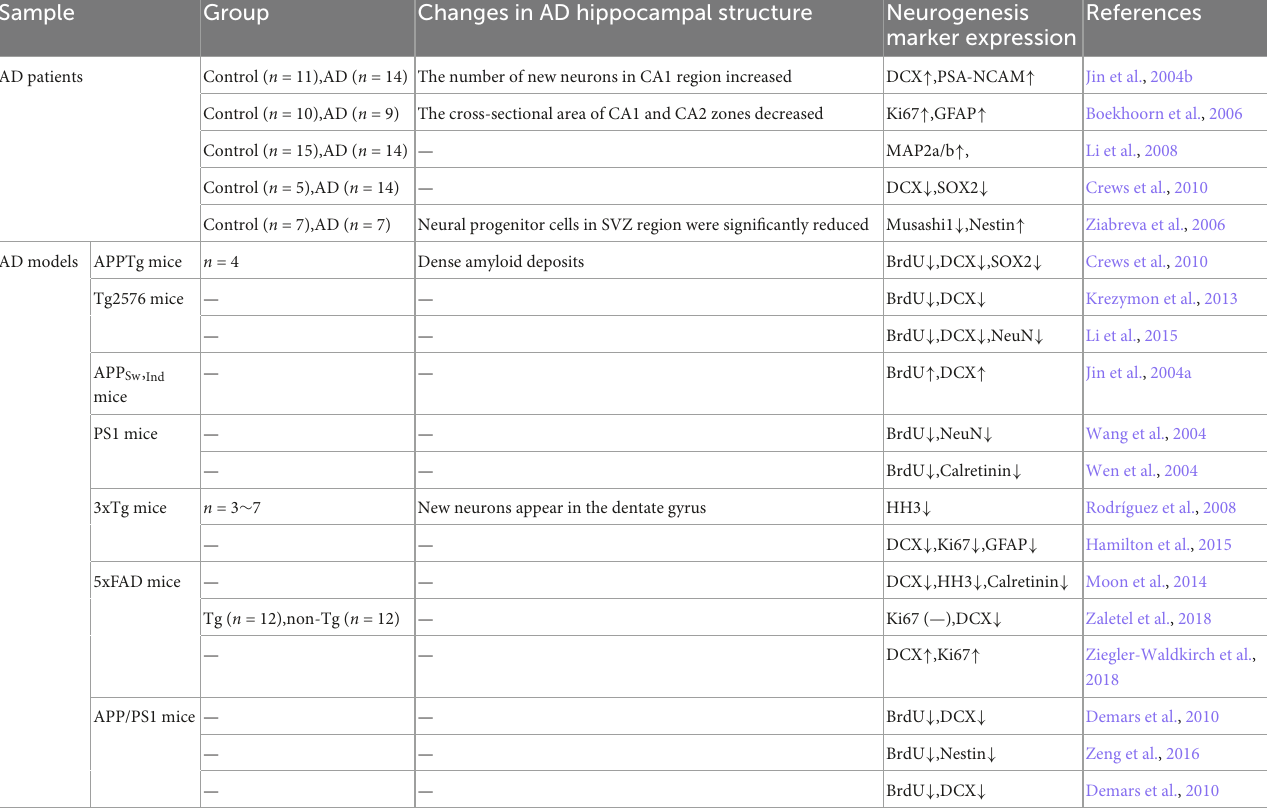
TABLE 1 Summary of adult hippocampal neurogenesis in AD patients and model mice.